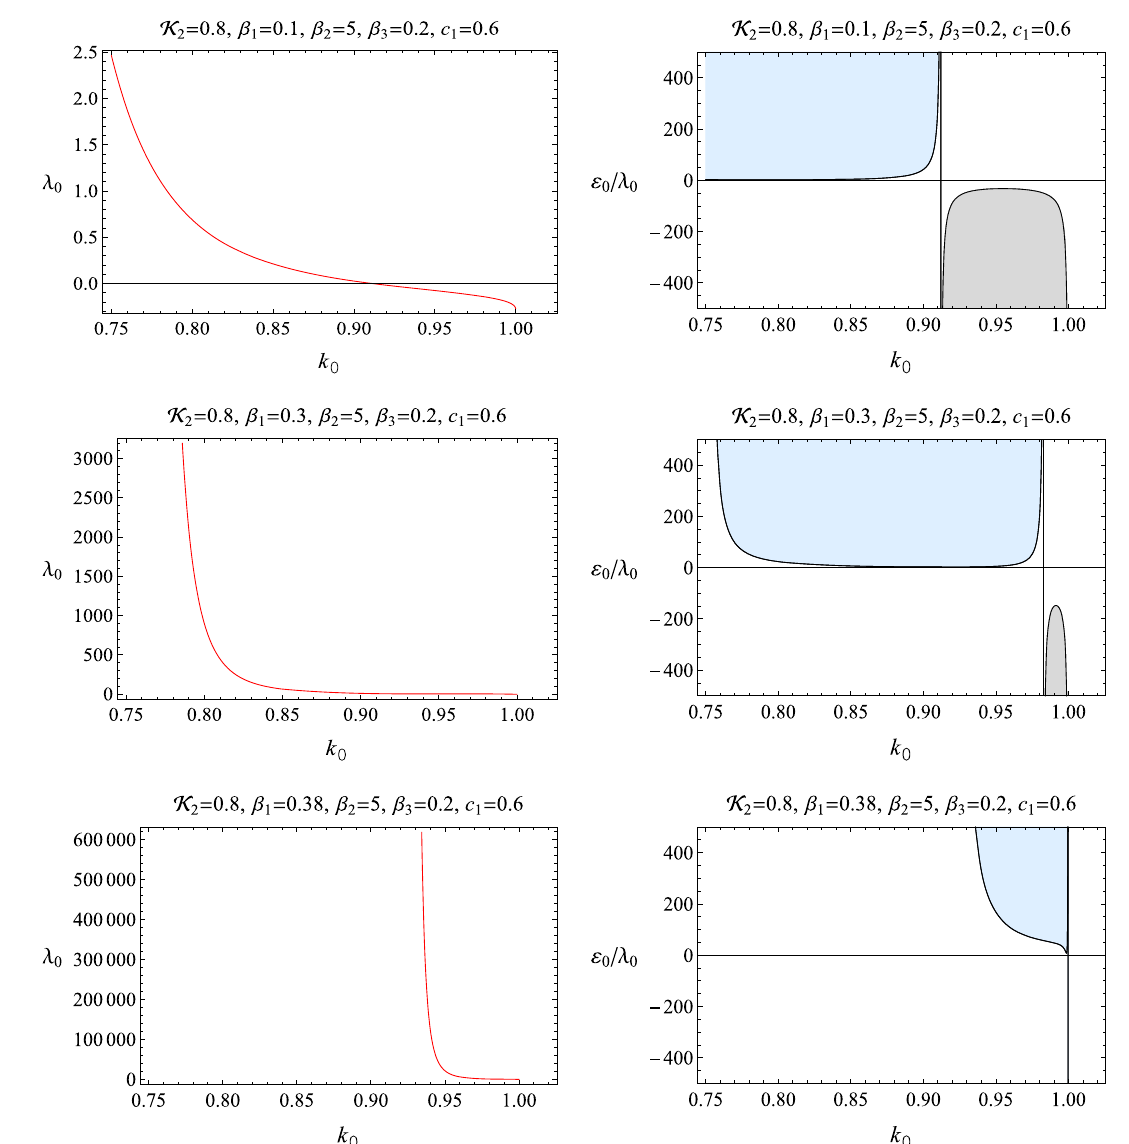
Fig. 10 Stable regions for the choice of first shape function (case(ii)) for different values of α 1 . Here, the shaded regions show the stable regions of developed